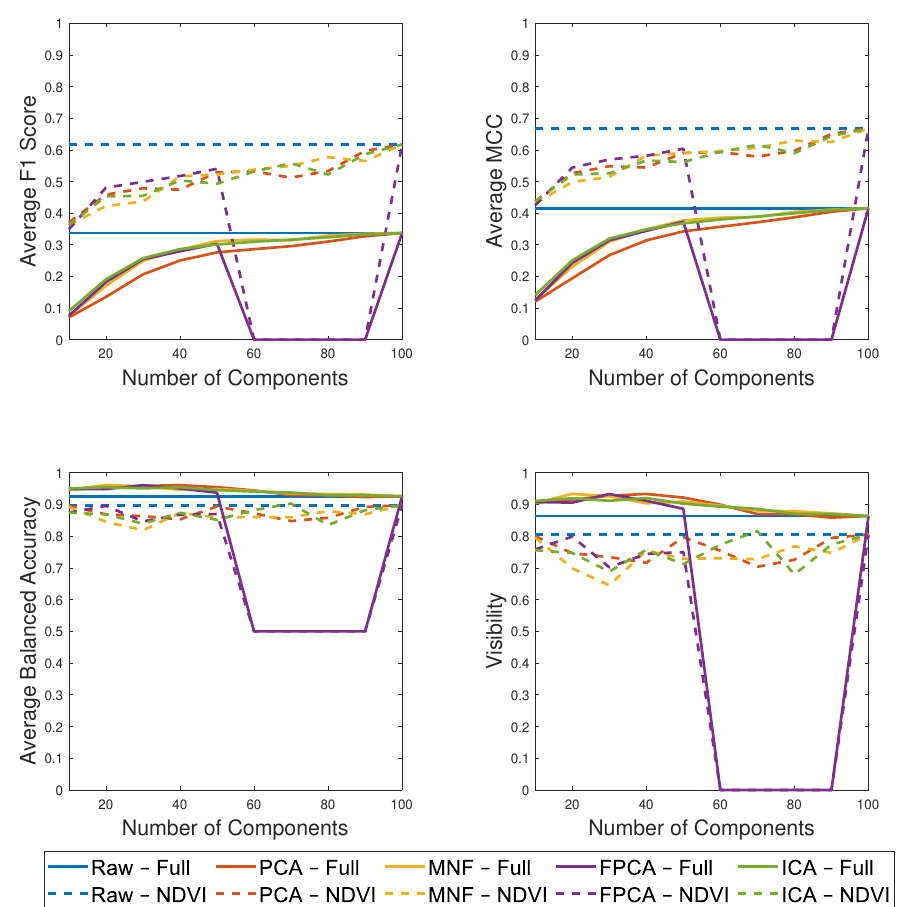
Figure 10. Performance measures using the ACE TD algorithm and each DR scheme with a varying number of retained components on the OP7